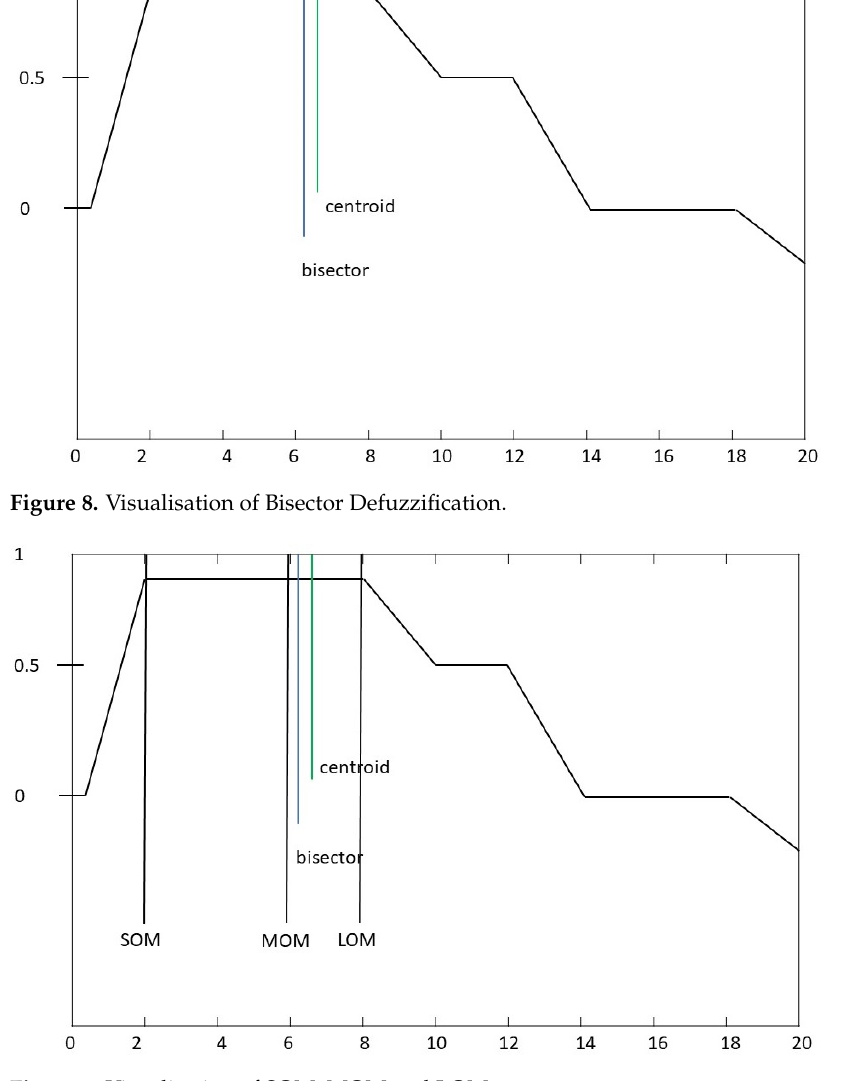
Figure 9. Visualisation of SOM, MOM and LOM.